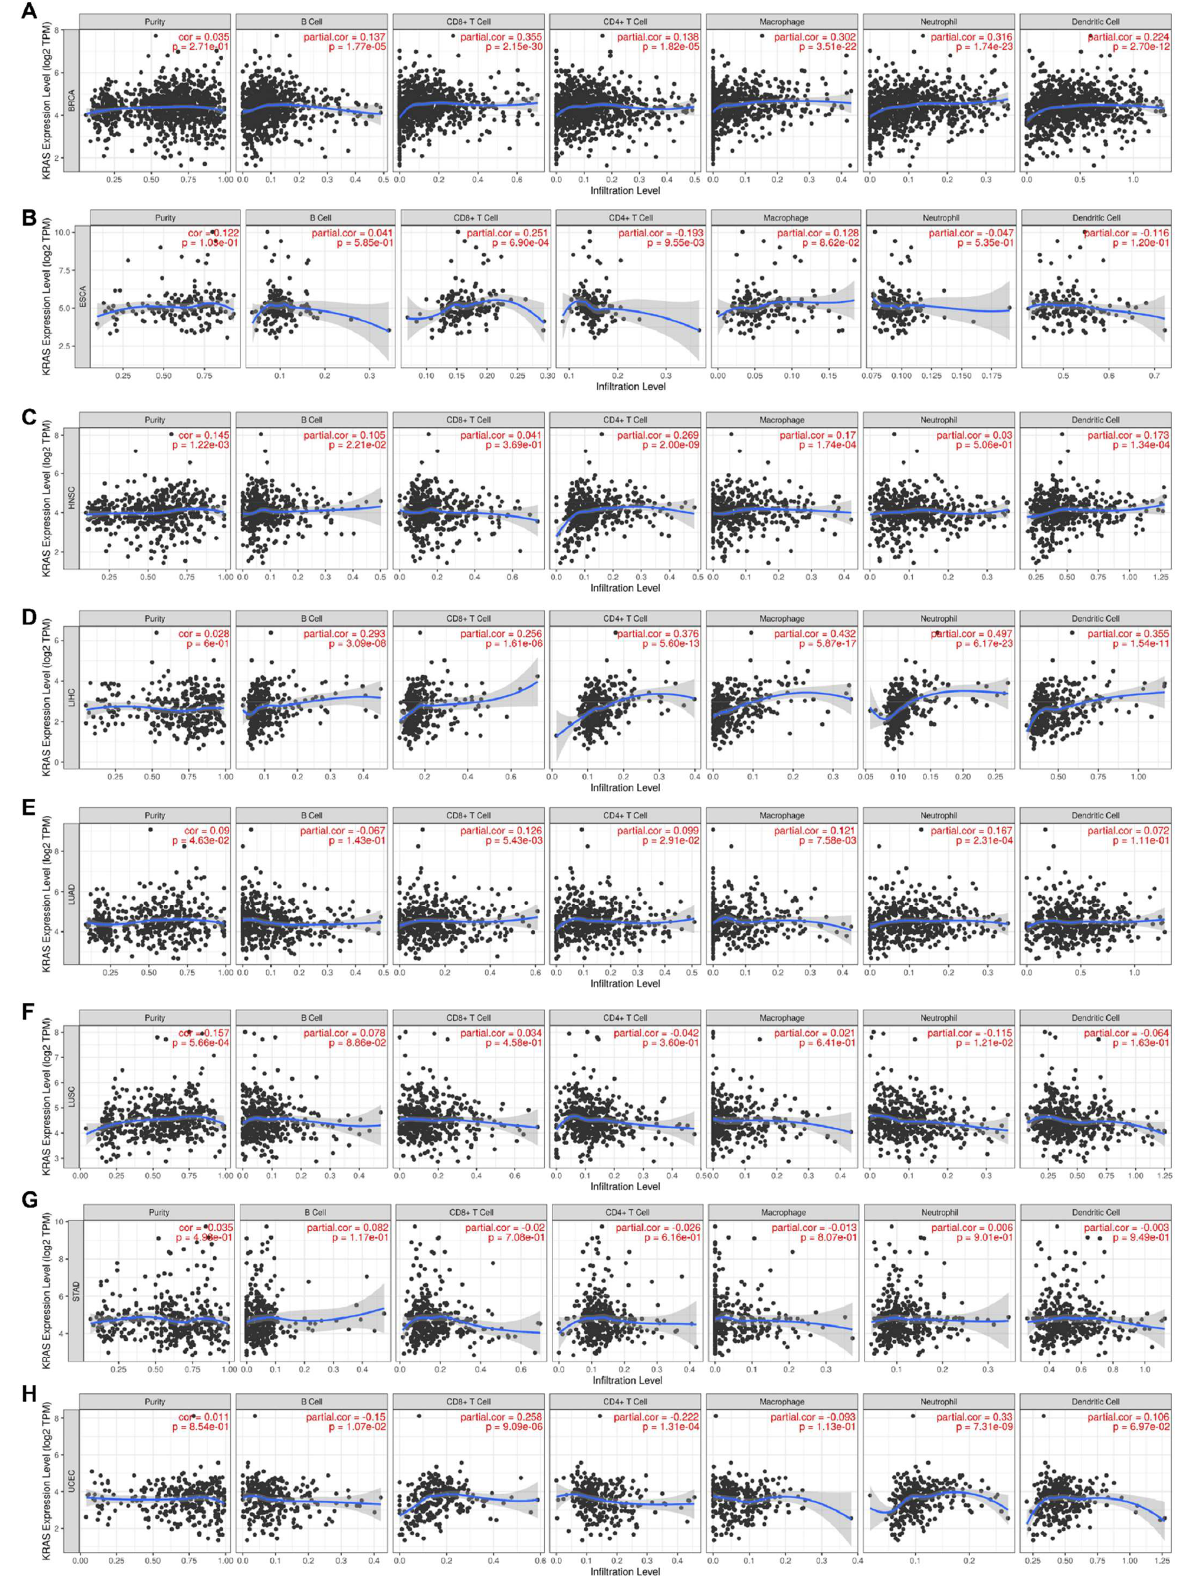
Figure 9. Correlation between KRAS and immune cell infiltration (B cells, CD8+T cells, CD4+T cells, macrophages, neutrophils, and dendric cells) in BRCA ( A ), ESCA ( B ), HNSC ( C ), LIHC ( D ), LUAD ( E ), LUSC ( F ), STAD ( G ), and UCES ( H ). A p -value < 0.05 was considered a significant